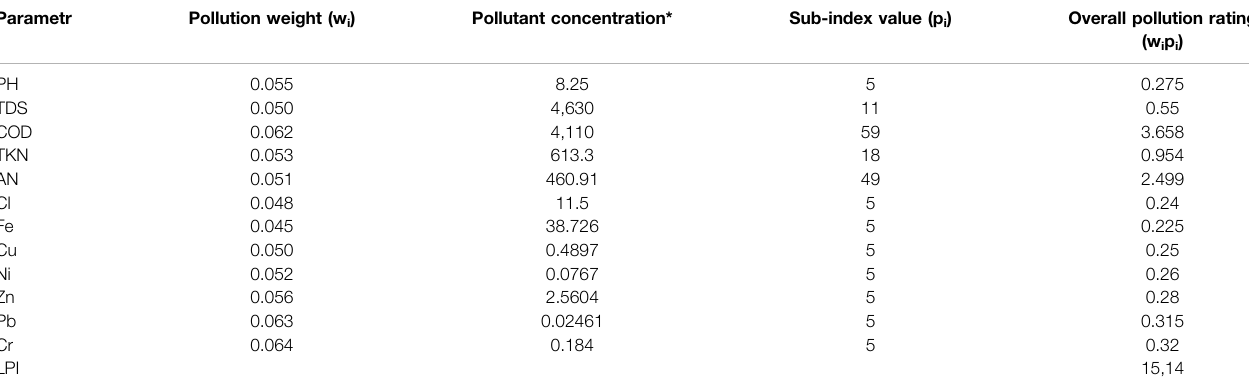
TABLE 2 | Leachate pollution index (LPI) calculation results-Jawor land fi ll 12.2019. Parametr